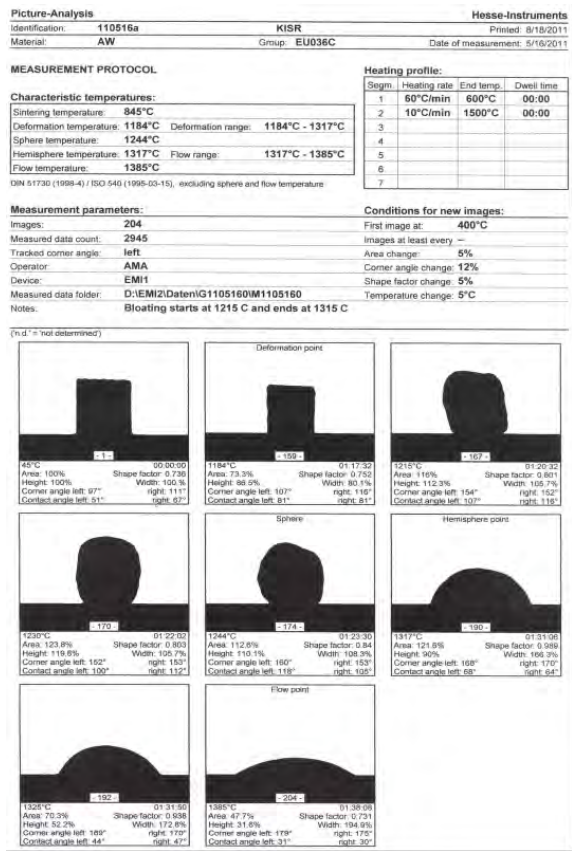
Figure 2. Heating microscope melting graphs of the